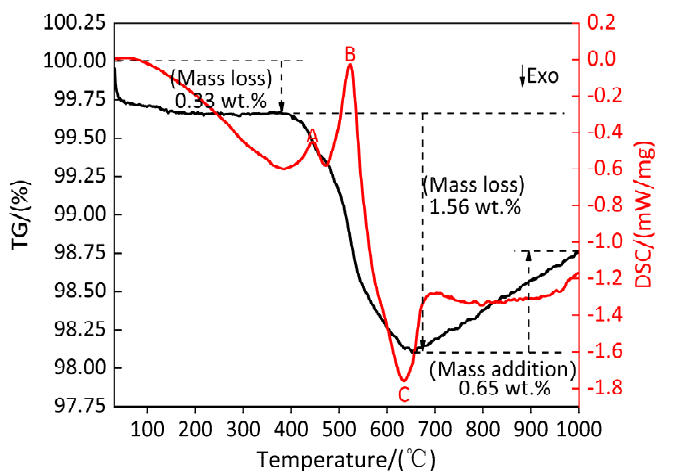
Figure 13. XRD patterns of sample Al at peak temperature and 1000 °C. ( a ) XRD pattern at 661.7 °C; ( b ) XRD pattern at 1000 °C.